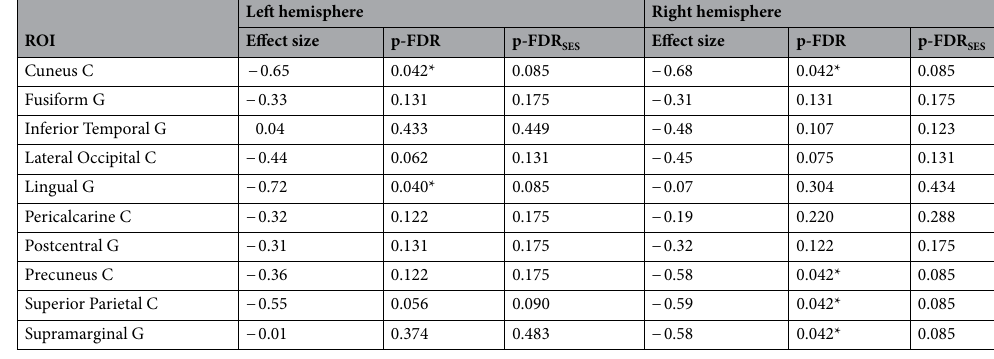
Table 4. Cohen’s d effect sizes and false-discovery rate (FDR) corrected p-values for associations between ScreenQ and cortical thickness for selected regions of interest (ROIs) defined by the Desikan-Killiany cortical atlas and shown in Fig. 3. Negative signs added to effect sizes indicate a negative association between ScreenQ score and cortical thickness. p-FDR false-discovery rate corrected p -value controlling for age and sex, p-FDR SES false-discovery rate corrected p -value controlling for age, sex and socioeconomic status (maternal education), C cortex, G gyrus. *Signifies that p-FDR is less than 0.05, defined as statistically significant (p-FDR < 0.10 is defined as marginally statistically